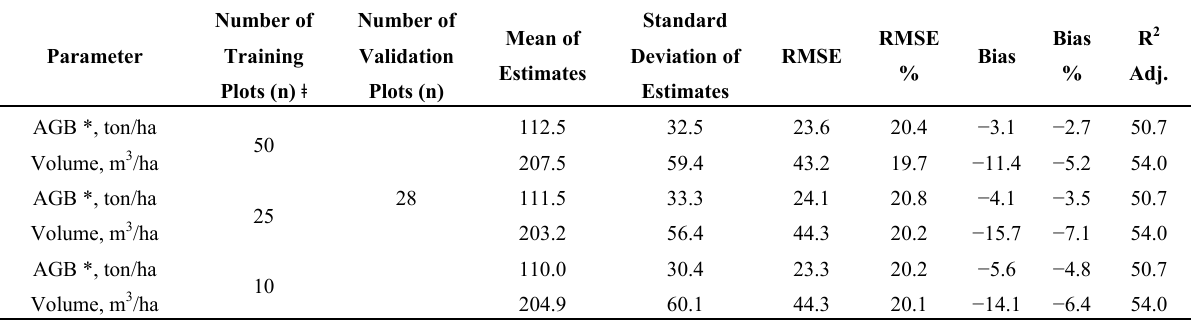
Table 7. Accuracy of AGB and volume obtained from RapidEye at validation plots.